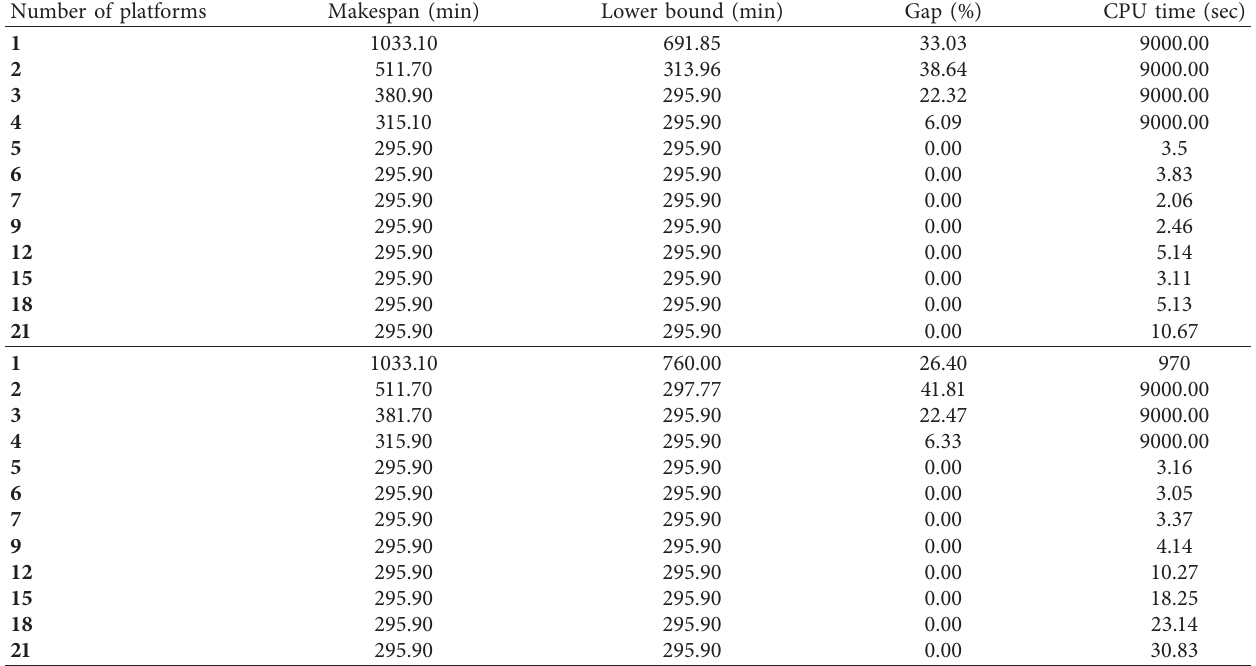
Table 5: Obtained results for the future scenario of refrigerated products in C